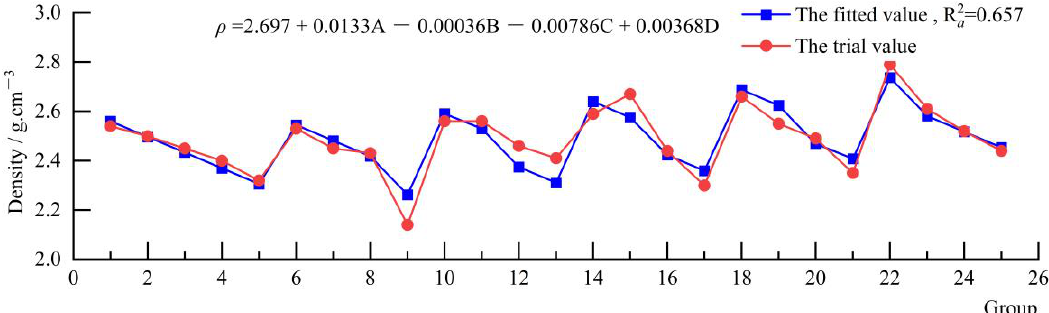
Figure 4. Comparison of fitted and experimental results for density.